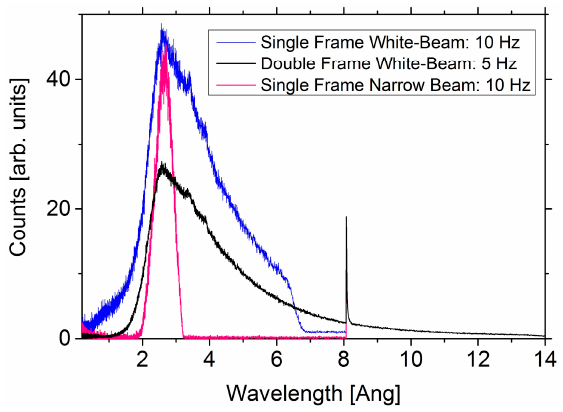
Figure 4. Beam spectra for different chopper settings, not corrected for efficiency: single-frame white-beam; narrow-bandwidth (pink) beam; double frame white-beam. The spike at 8.1 Å is the gamma pulse originating when the protons hit the target, in the absence of the T 0 chopper. Data were collected in histogram mode for neutron counts as a function of the neutron time-of-flight with a logarithmic time bin of Δ T / T = 0.001 in a range between 5 μ s to 100 ms and 5 μ s to 200 ms for single-frame and double frame acquisitions, respectively.